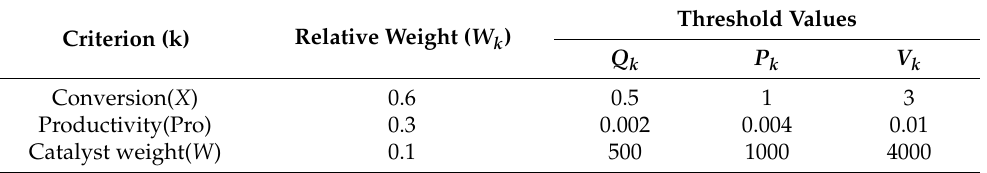
Table 5. Relative weights ( W k ), and indifference ( Q k ), preference ( P k ), and veto ( V k ) thresholds for each objective that are used in the NFM algorithm to rank the entire Pareto